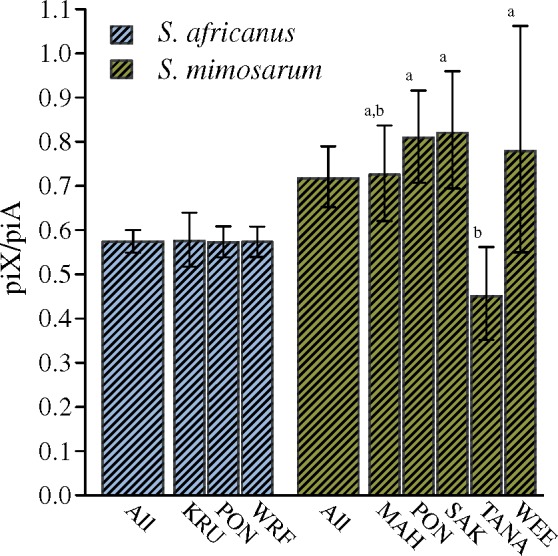
Ratios of X chromosome to autosome genetic diversity (piX/piA) based on pi estimates presented in figure 5. Estimates are presented for three populations of Stegodyphus africanus (WRF, PON and KRU) and five populations of S. mimosarum (MAH, SAK, TANA, WEE and PON), as well as the species average (ALL). Significant differences (indicated by different letters) between populations within each species were investigated using F-tests and Tukey’s HSD method for post hoc comparisons. Error bars represent 95% confidence limits obtained by bootstrapping.